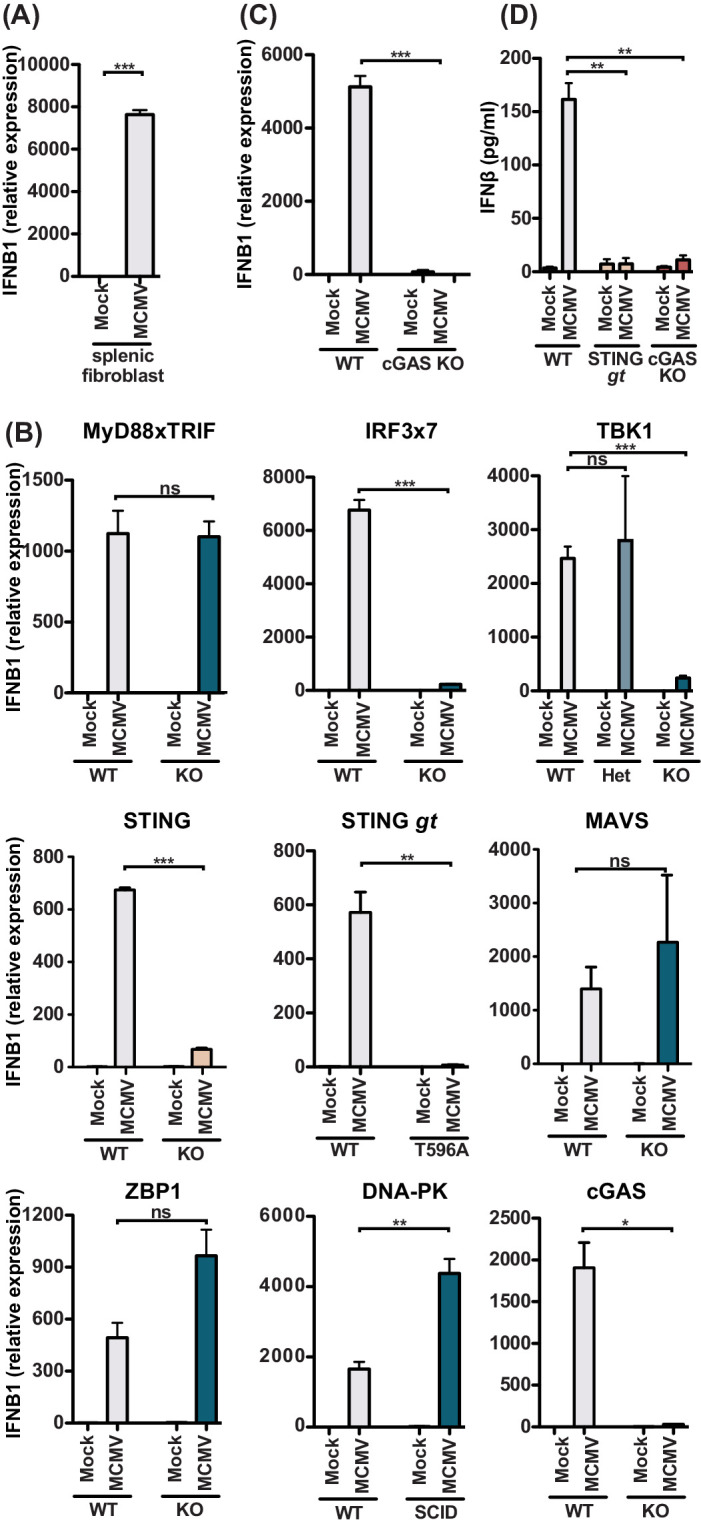
MCMV-induced fibroblast IFNβ is triggered by cGAS-STING-dependent but MyD88-Trif-MAVS-independent mechanisms.(A) IFNB1 mRNA levels of primary splenic fibroblasts infected with WT1 MCMV (MOI = 5) 8 hr post-infection. (B) IFNB1 mRNA levels of murine embryonic fibroblasts (MEF) from wildtype (WT) or indicated deficient mice were infected and analyzed as in (A). (C) IFNB1 mRNA levels in infected WT or cGAS-deficient primary splenic fibroblasts, analyzed as in (A). (D) Secreted IFNβ by WT or indicated gene deficient MEF, infected with MCMV (MOI = 0.5); supernatant was analyzed 48 hours p.i. by ELISA. Panels show representative experiments from two independent experiments performed in duplicate. WT, STING GT, and TBK1-, MAVS-, ZBP1-, DNA-PK-, and cGAS-deficient MEF represent data from two independent MEF preparations. Error bars indicate SEM; ns, not significant, *p<0.05, **p<0.01, ***p<0.001.
Figure 5—source data 1.MCMV-induced fibroblast IFNβ is triggered by cGAS-STING-dependent but MyD88-Trif-MAVS-independent mechanisms.